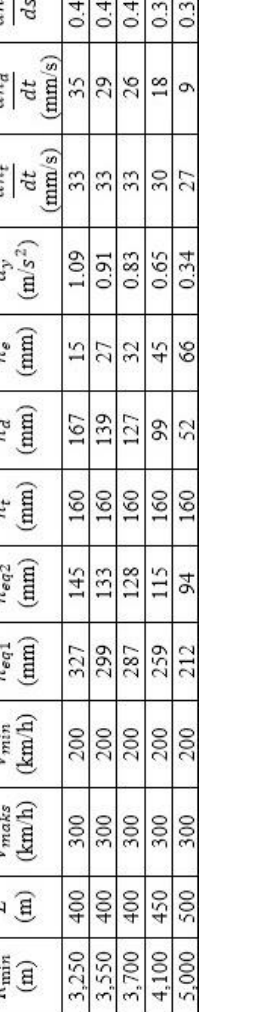
Table 3. Magnitudes of forces affecting the vehicle in the curves